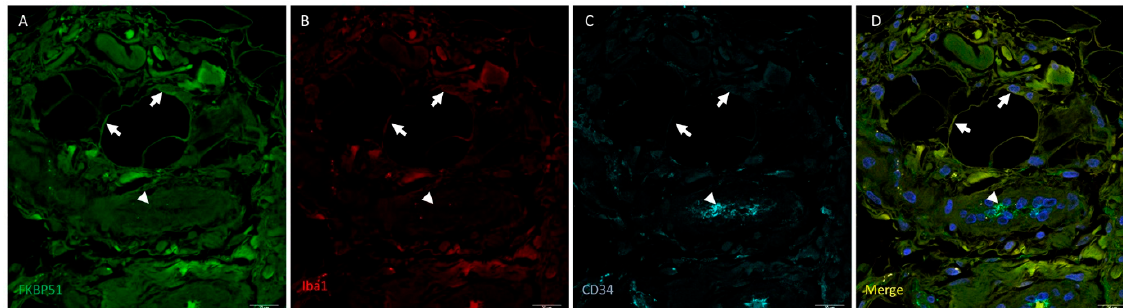
Figure 5. Triple immunolabelling for FKBP51 (green), Iba1 (red) and CD34 (cyan) in Hoffa’s fat pad tissue sections from a patient with knee OA (grade IV). Merges also contain DAPI staining. FKBP51 fluorescence is localized in the cytoplasm and nuclei of virtually all cells at a medium-high intensity level (arrows in A). Iba1+ staining in cytosol of adipocytes (arrows). Arrowheads point to FKBP51+/CD34+ endothelial cells (( A , C , D ) panels), Iba1- (panel ( B )).